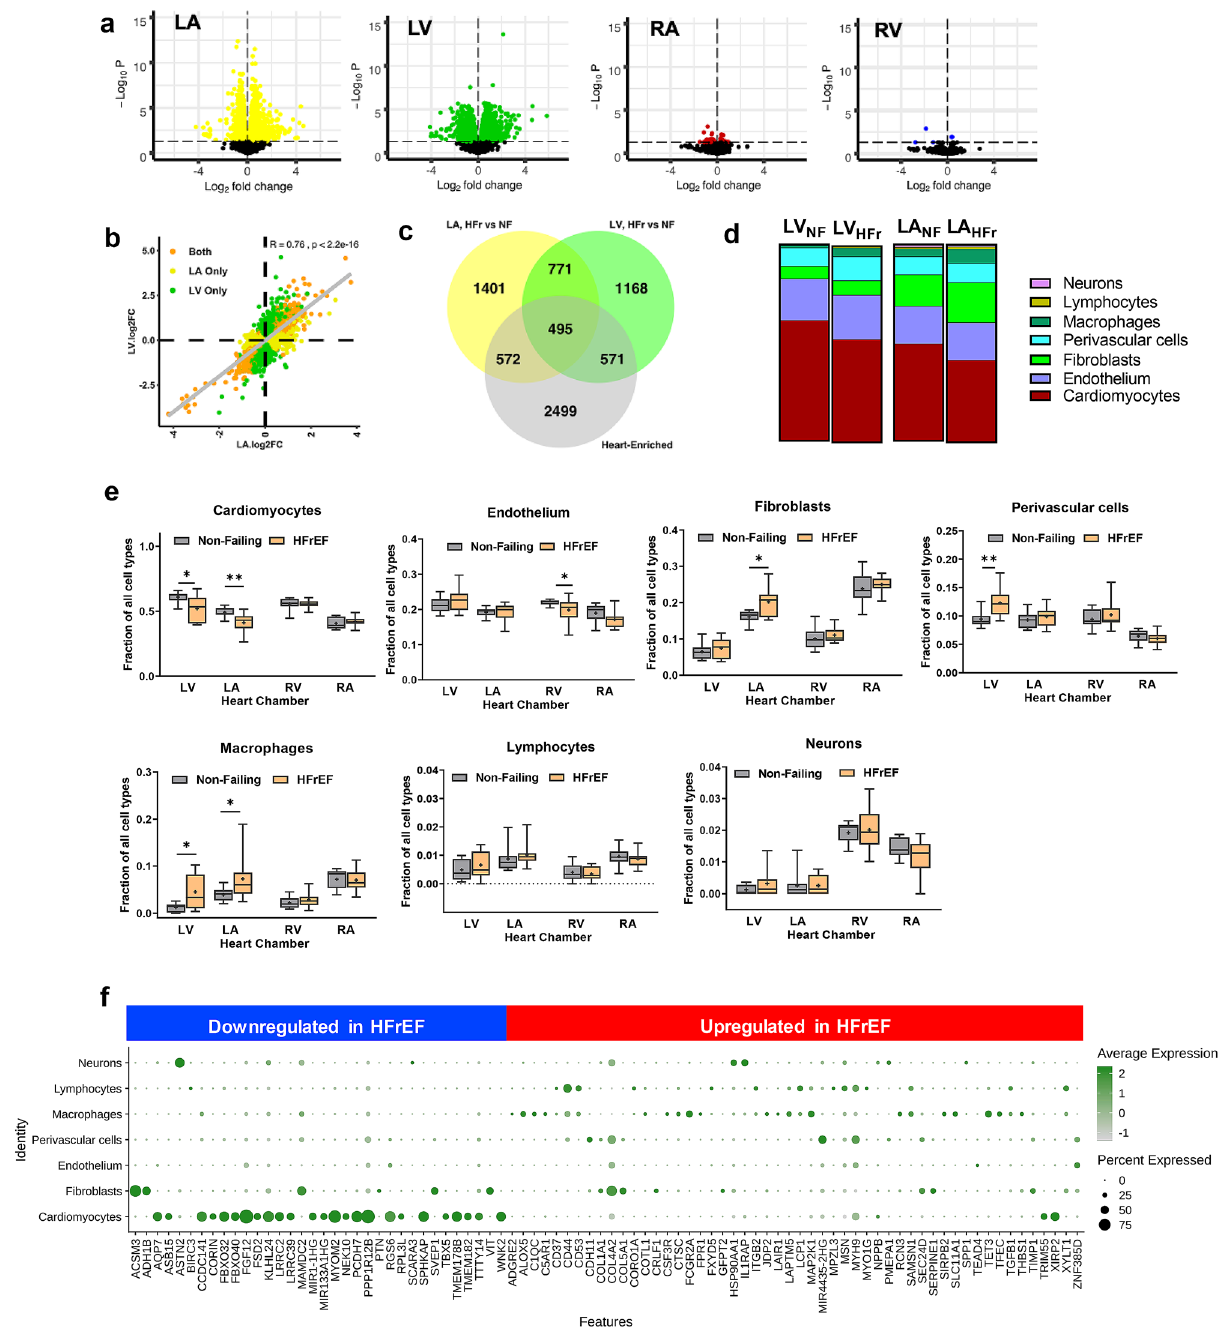
Figure 5. HFrEF-diseased heart displayed regional and cellular alterations in gene expression profiles. ( a ) Volcano plots represent differentially expressed genes (DEGs) in HFrEF versus Control in each heart chamber. Genes with BH adjusted p value < 0.05 are color-marked. ( b ) Correlation of DEG expression in LA and LV. Significantly altered DEGs in both LA and LV are marked orange, DEGs that are only significantly regulated in LA or LV are labeled as yellow and green respectively. Refer to Supplemental Table 5 for the number of genes that were classified into different regulatory groups by regulation direction in the LA and LV. ( c ) Venn diagram showing the intersection of HFrEF DE genes in the LA and LV with Heart-Enriched genes. ( d ) Averaged cellular composition (“part-of-whole” bars) and ( e ) fractions of each cell type (box plots) in the LA and LV of human non-failing (NF) and failing hearts (HFr) by SCDC deconvolution analysis. Significance between HFrEF and NF groups was evaluated by Mann Whitney test. Significant differences between the groups are indicated as exact p values. LV NF , left ventricle of non-failing heart. LV HFr , left ventricle of HFrEF heart. LA NF , left atrium of non- failing heart. LA HFr , left atrium of HFrEF heart. ( f ) Cell-type-specific gene expression distribution of selected Heart-Enriched DEGs (fold change less than 0.5 or more than twofold, BH adjusted p value < 0.01) in HFrEF left heart by single nucleus RNA-Seq. The size of dot indicates the percentage of cells with at least one transcript detected and the color of dot represents the scaled average expression level of expressing